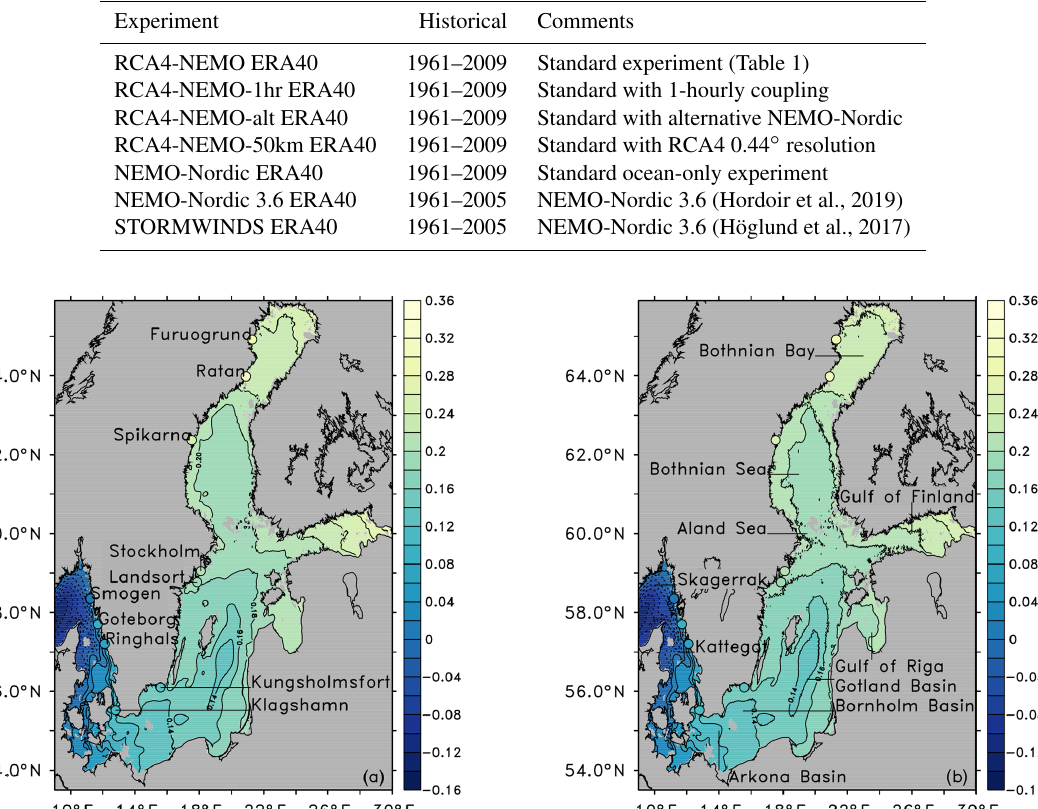
timated mean sea surface based on the tide gauge